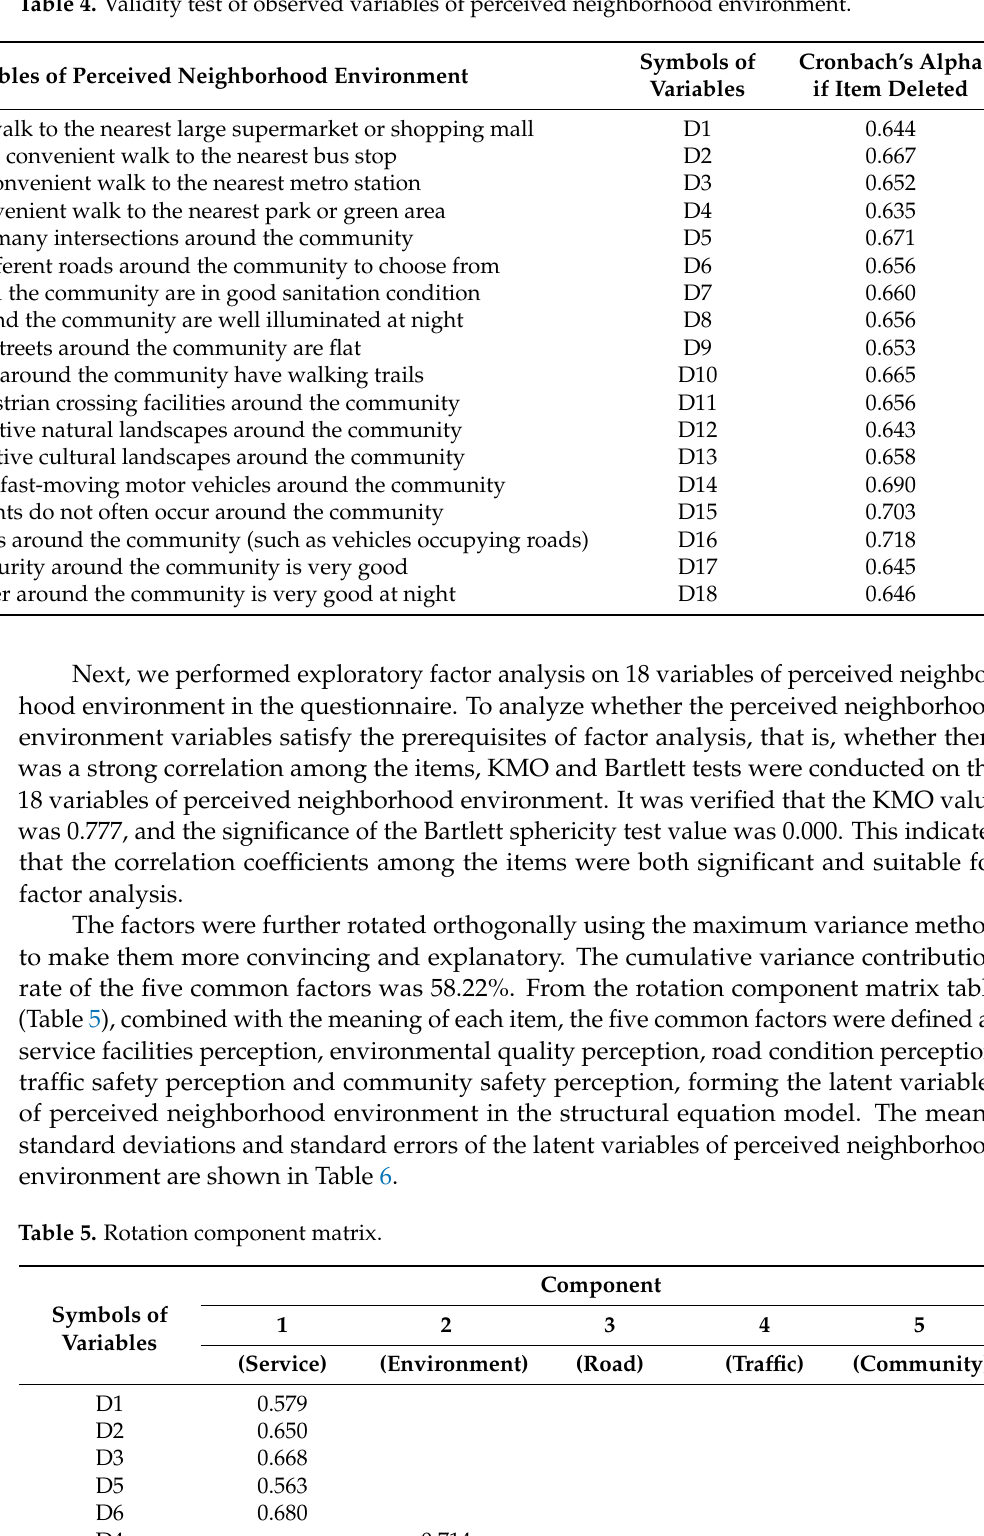
Table 4. Validity test of observed variables of perceived neighborhood environment.